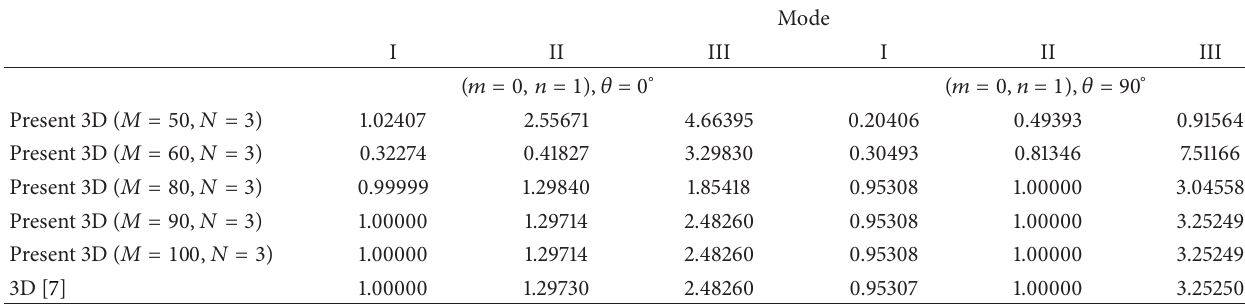
Table 4: Assessment 3. Simply supported orthotropic cylinder with thickness ratio ℎ/𝑅 𝛼 = 0.3 and orthotropic angle 𝜃 equal to 0 ∘ or 90 ∘ . First three exact natural circular frequencies in no-dimensional form 𝜔 = 𝜔(𝑅/𝜋)√𝜌/𝐺 12 for imposed half-wave numbers 𝑚 = 0 and 𝑛 = 1 . Comparison between present three-dimensional analysis and three-dimensional analysis by Soldatos and Ye [7]. 𝑀 is the number of fictitious layers and 𝑁 is the order of expansion for the exponential matrix.